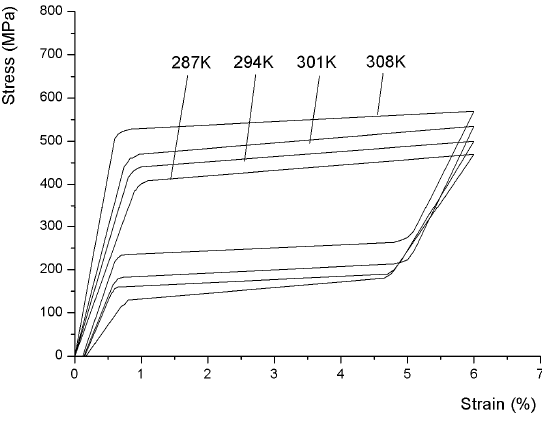
Figure 8 . The influence of various temperatures on NiTi wires.